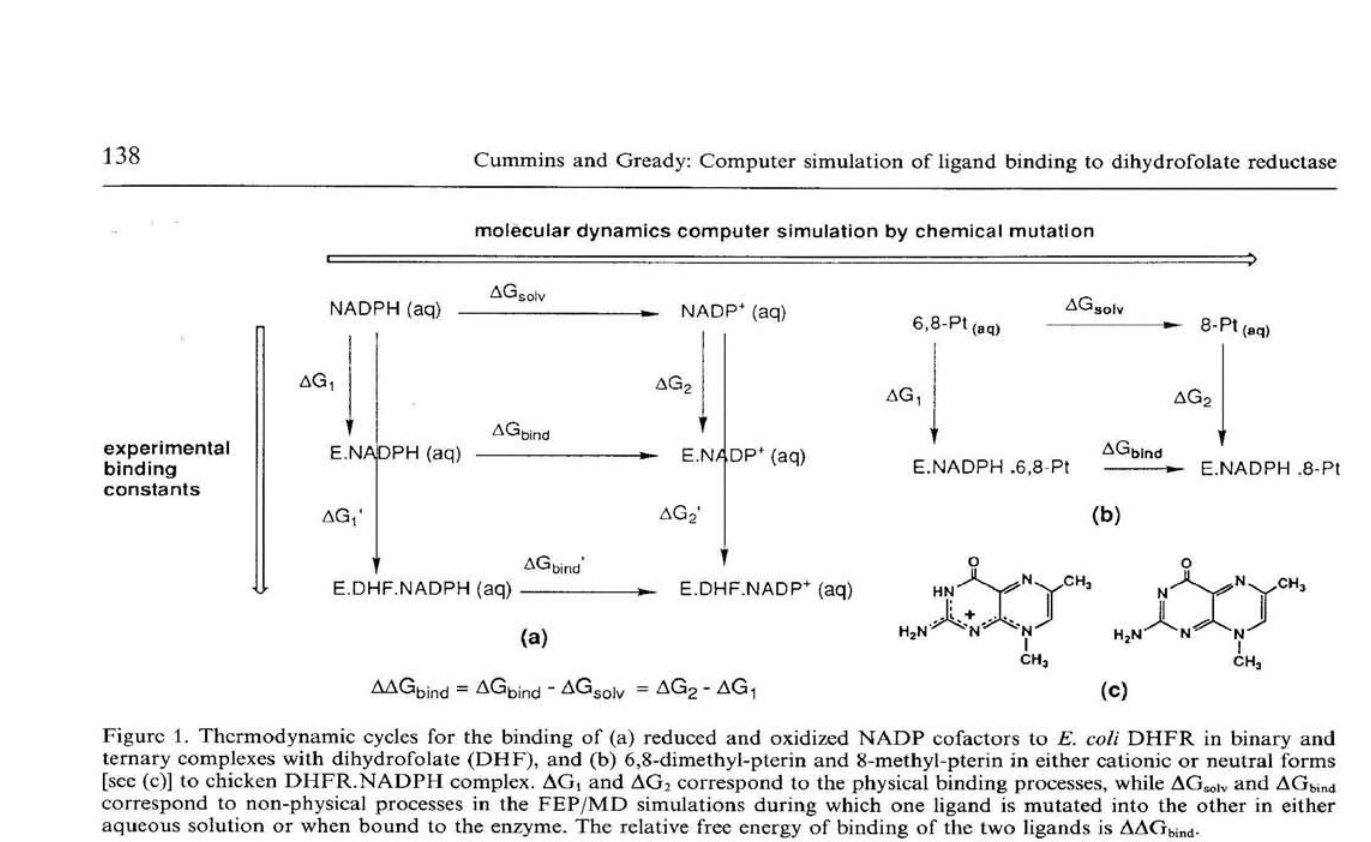
Binding of neutral and cationic forms of 8-methyl- pterins to chicken DHFR.NADPH complexes